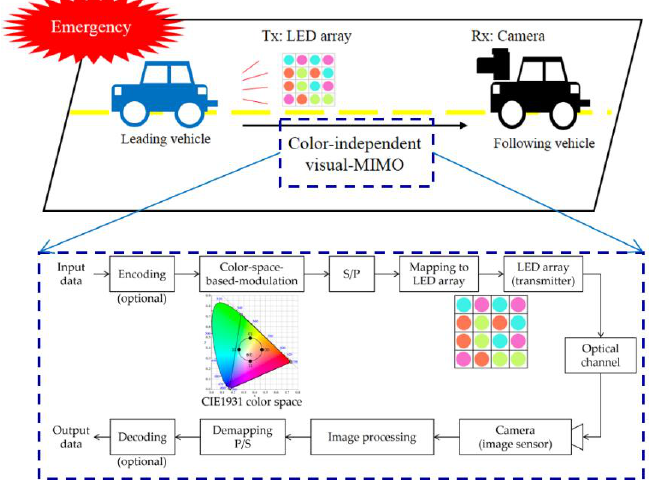
Supplementary Materials: Figure S1: The illustration of V2V communication using color-independent visual-MIMO.